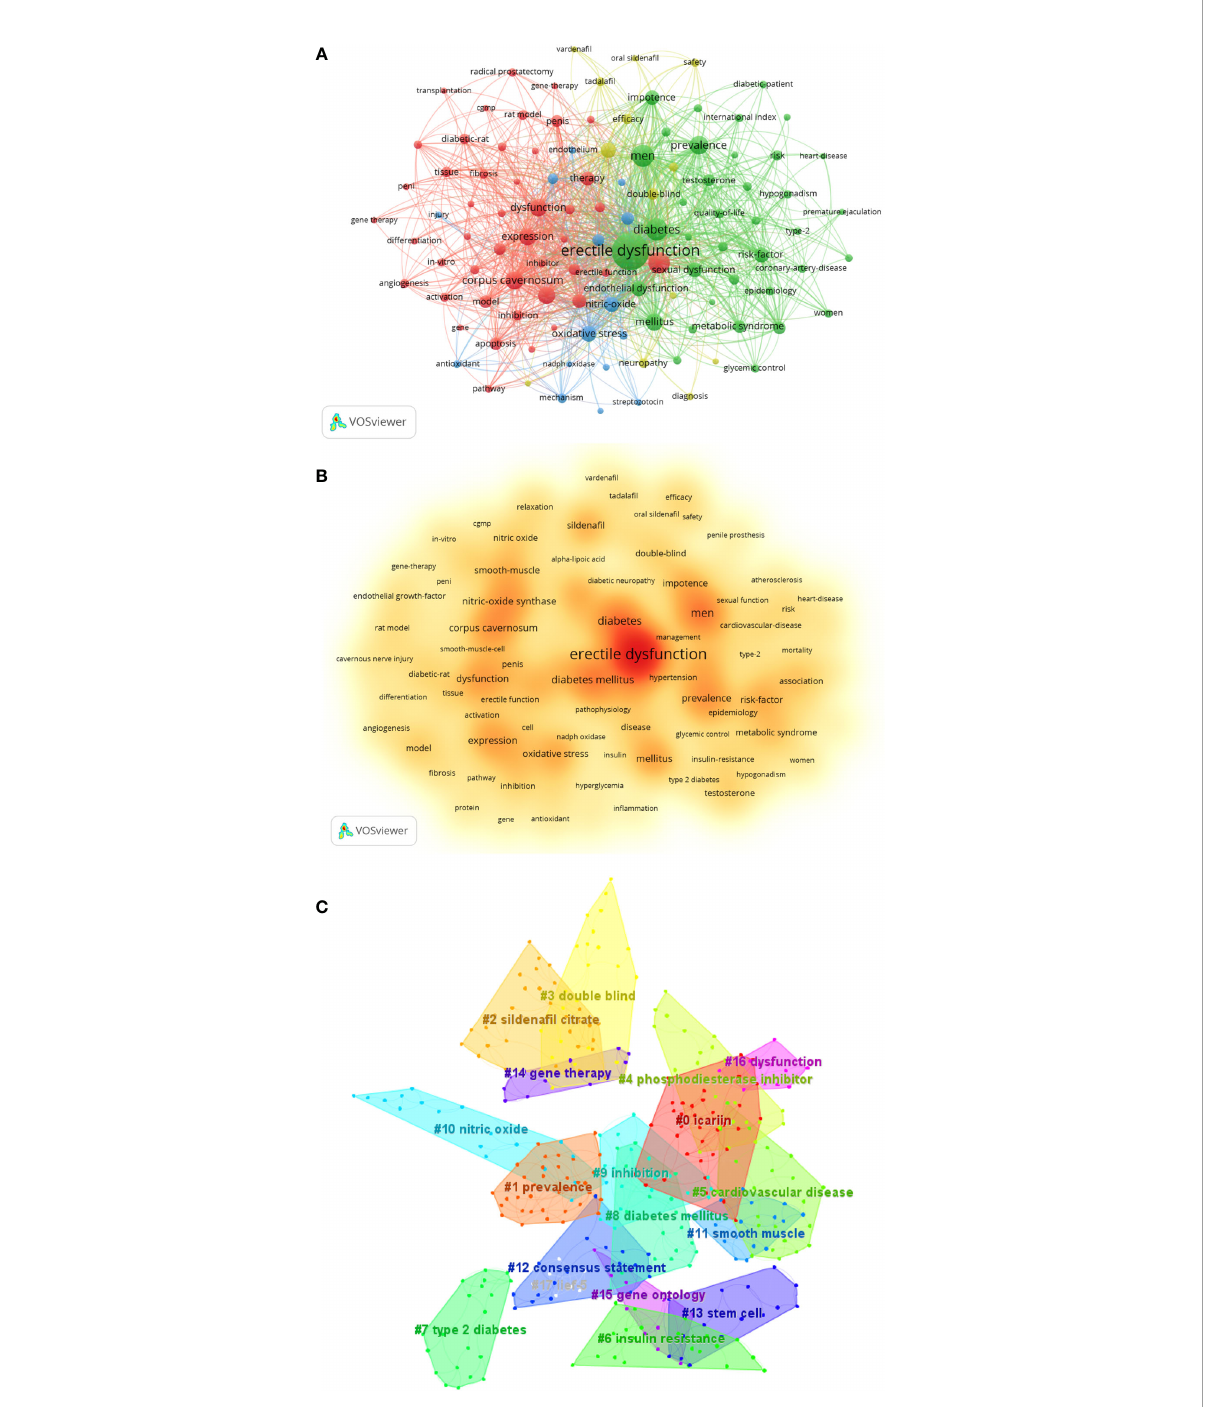
FIGURE 9 Keyword analysis. (A) Map of the keyword co-occurrence analysis obtained using VOSviewer. The size of the nodes represents the number of occurrences; the thickness of the curve represents the strength of collaboration; the different colors represent the different clusters. (B) Keyword density visualization analysis. The redder the node color, the higher the frequency of the keyword. (C) Keyword clustering map analysis using CiteSpace. A total of 16 categories of keywords were obtained; the different color blocks represent different keyword